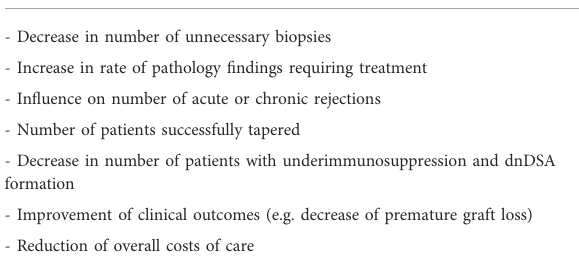
TABLE 3 Metrics for monitoring impact of implementation (Oellerich et al.,